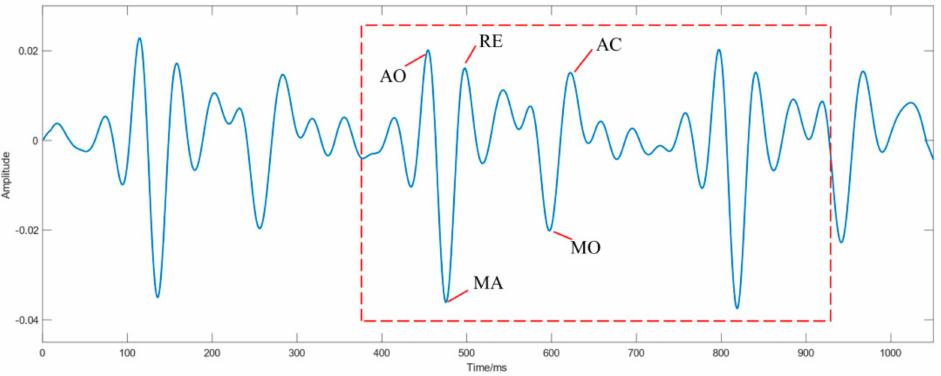
Figure 3. Typical SCG